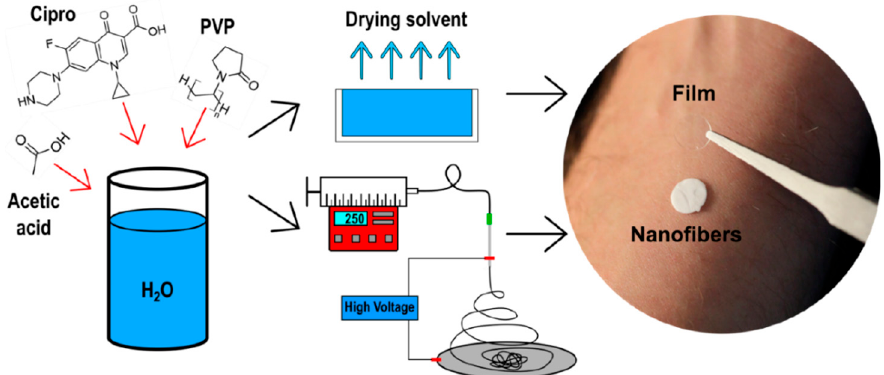
Figure 1. Schematic representation of the methods used for the film and nanofiber mat fabrication, and pictures of the discs used in the experimental set up. Cipro—ciprofloxacin; PVP—polyvinylpyrrolidone.